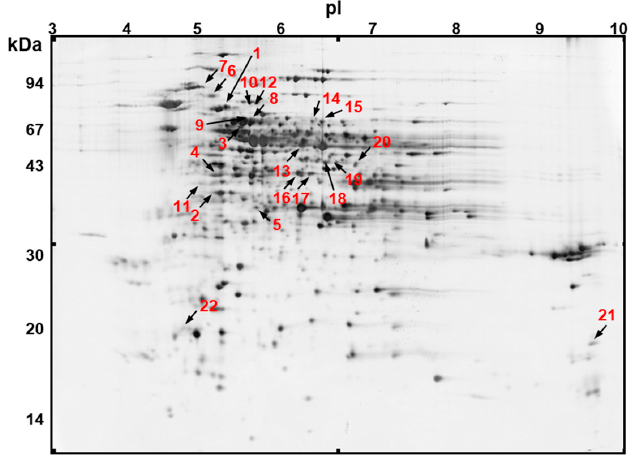
Figure 1. Position of varying spots on 2D silver-stained master gel of cauliflower curd mitochondrial proteome (in total 100 µg of mitochondrial proteins pooled from all experimental variants), including 694 repeatable spots. 24-cm immobilised pH gradient strips (linear pH 3–10) for the first dimension and precast Ettan DALT 12.5% SDS-polyacrylamide gels for the second dimension were used. It shows the position of the 22 variable spots that were mapped and identified (they appear also in Figures S1, S2 and Table 1). Protein molecular mass standards (Thermo Scientific, Gda ń sk, Polska) sizes are given in kilodaltons (kDa); pI-isoelectric point. Further experimental details in Materials and Methods.